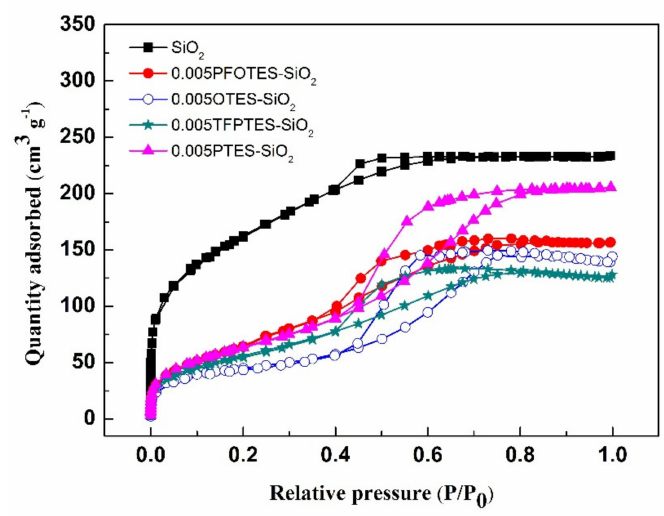
Figure 6. Nitrogen adsorption-desorption isotherms of pristine and silylated silica xerogels.